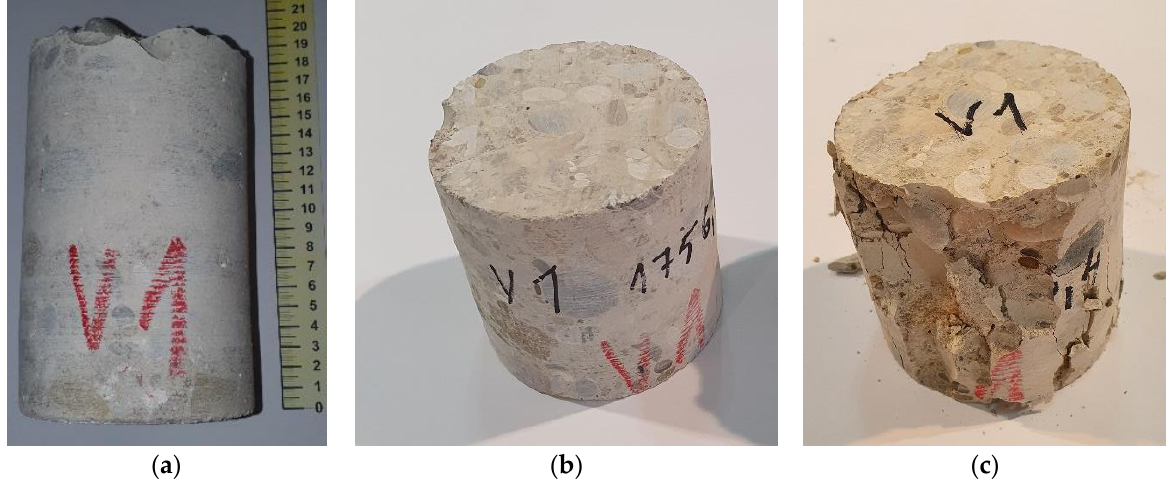
Figure 9. Extracting concrete samples in the column on the ground floor ( a ) and a wall on the 2nd floor ( b ).